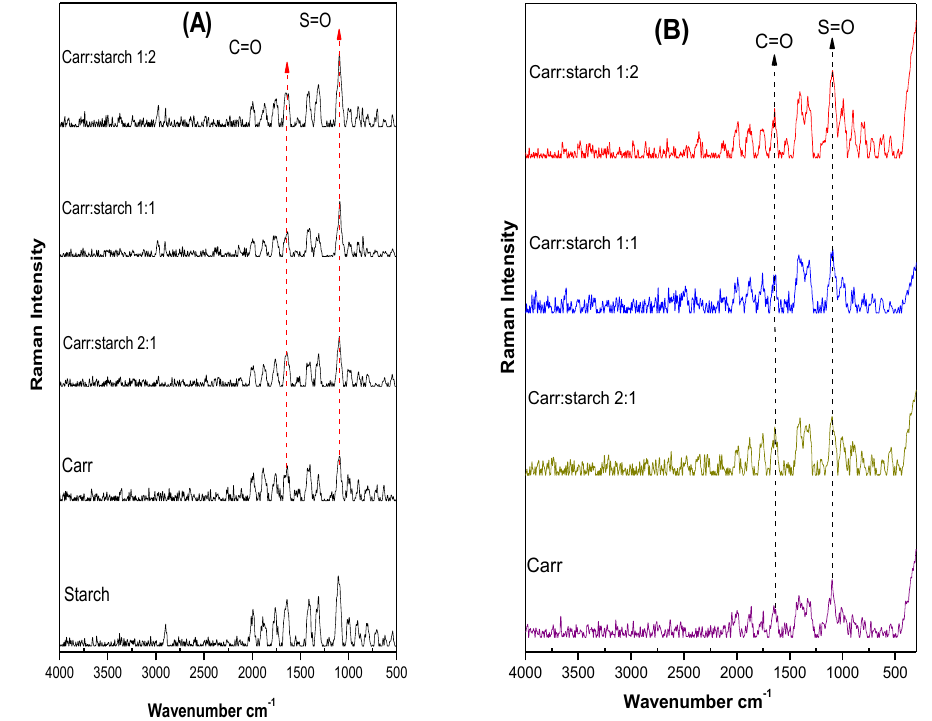
Figure 3. Raman scattering spectra of κ -carrageenan, starch, and Carr/starch blend-based membranes before ( A ) and after ( B ) treatment with amylase enzyme.